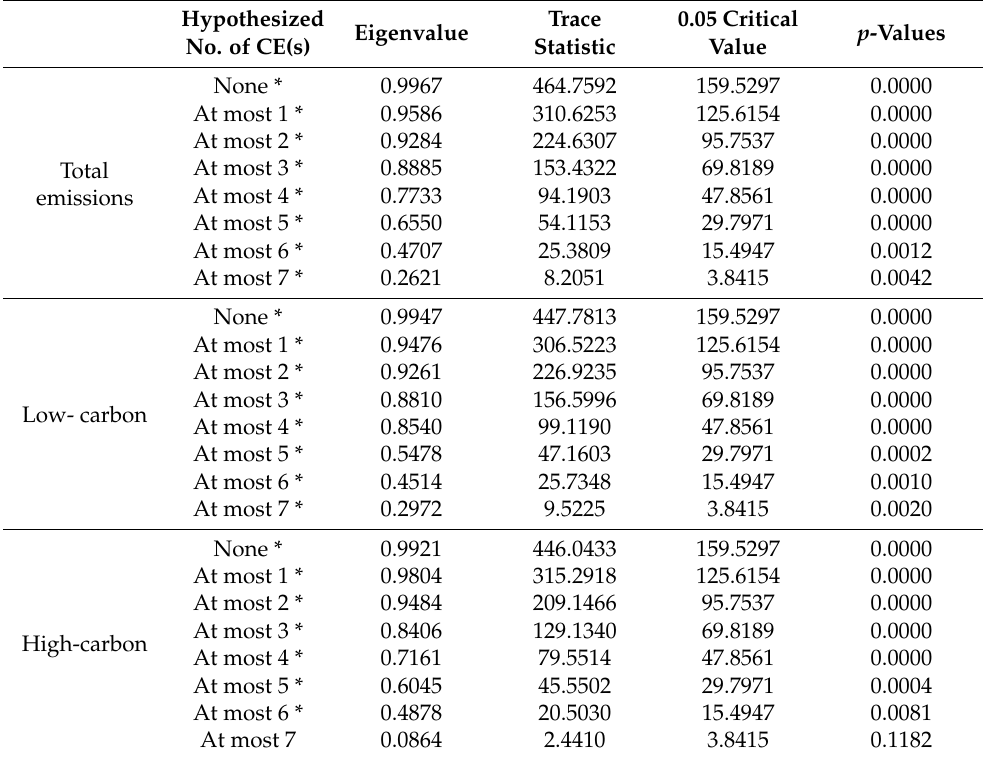
Table A3. The Johansen cointegration test